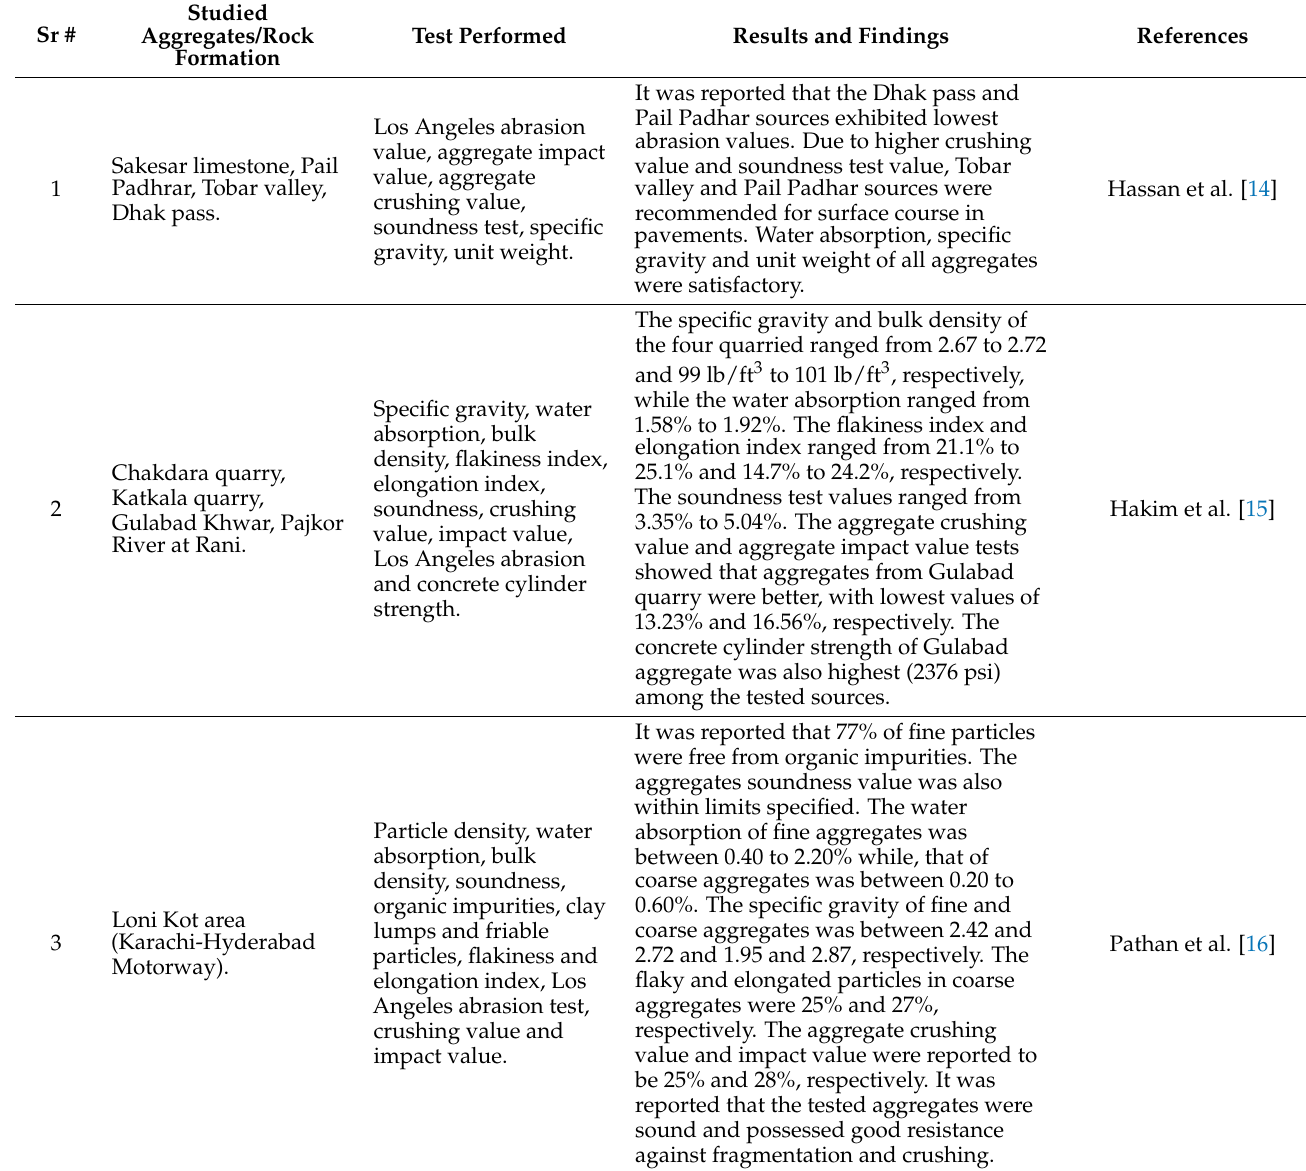
Table 1. Previous studies conducted on local